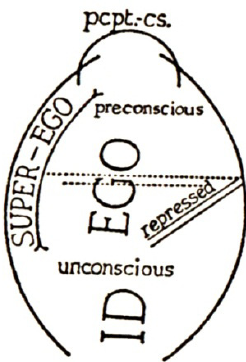
Figure 3. Freud’s final model of the mental apparatus. Pcpt.-Cs. = Perceptual-Consciousness system. Reproduced from [17] with